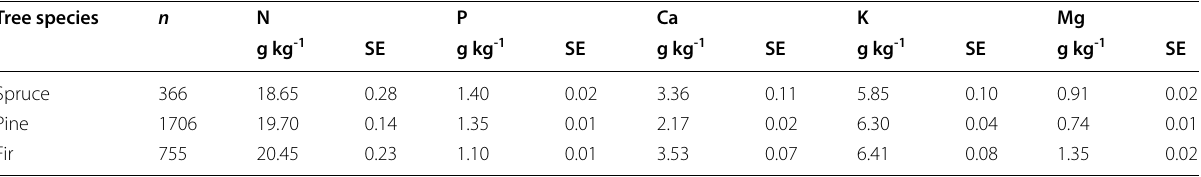
Table 5 Nutrient concentrations in foliage (mean and standard error, SE) for ever green species Tree species n